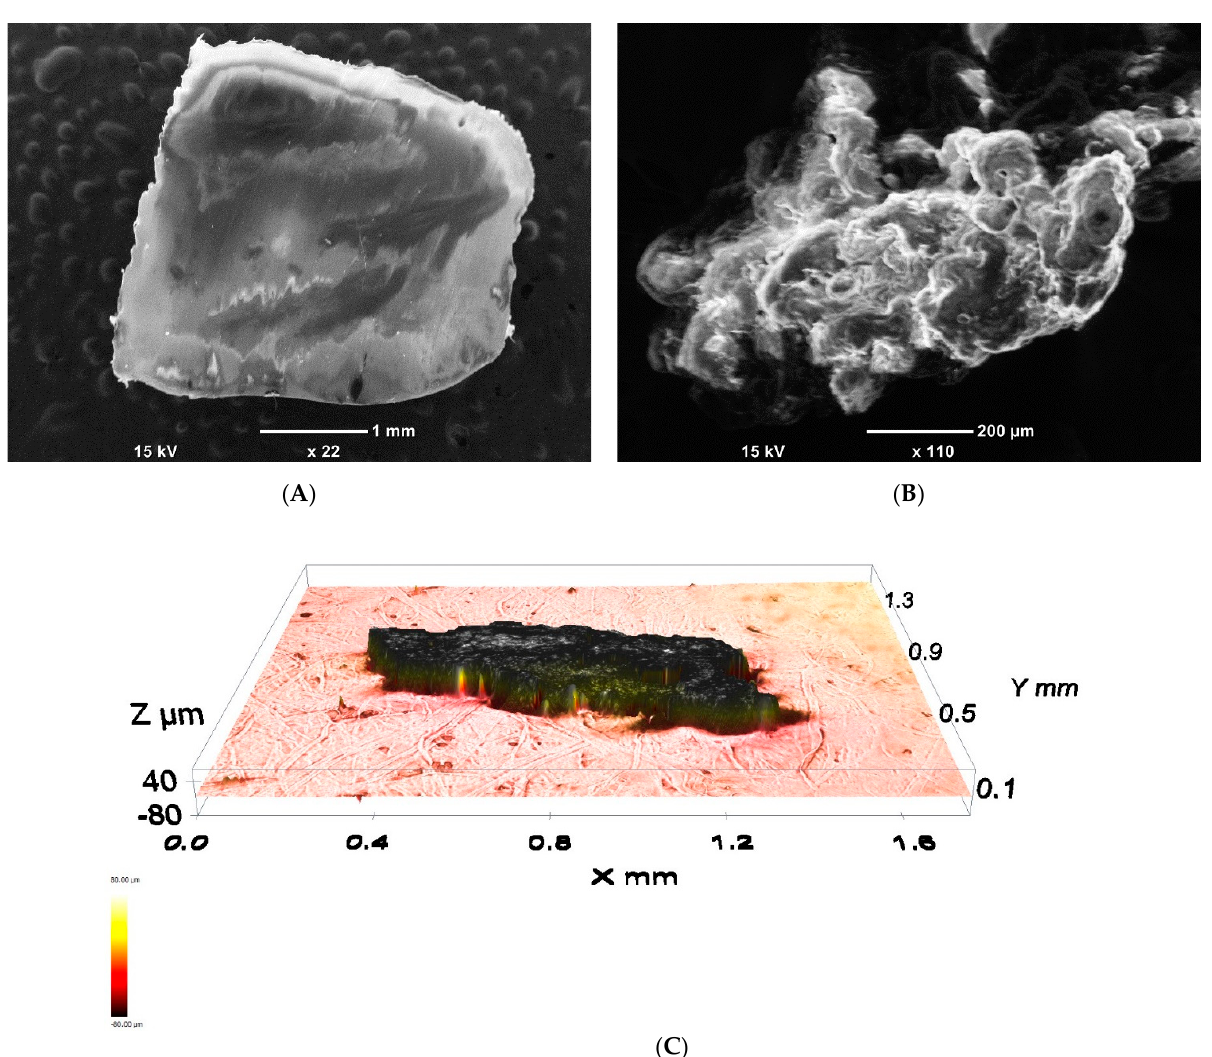
Figure 3. SEM micrograph of a common as-produced LDPE pellet ( A ), SEM micrograph ( B ) and profilometry image ( C ) of LDPE powder prepared by grinding (unpublished